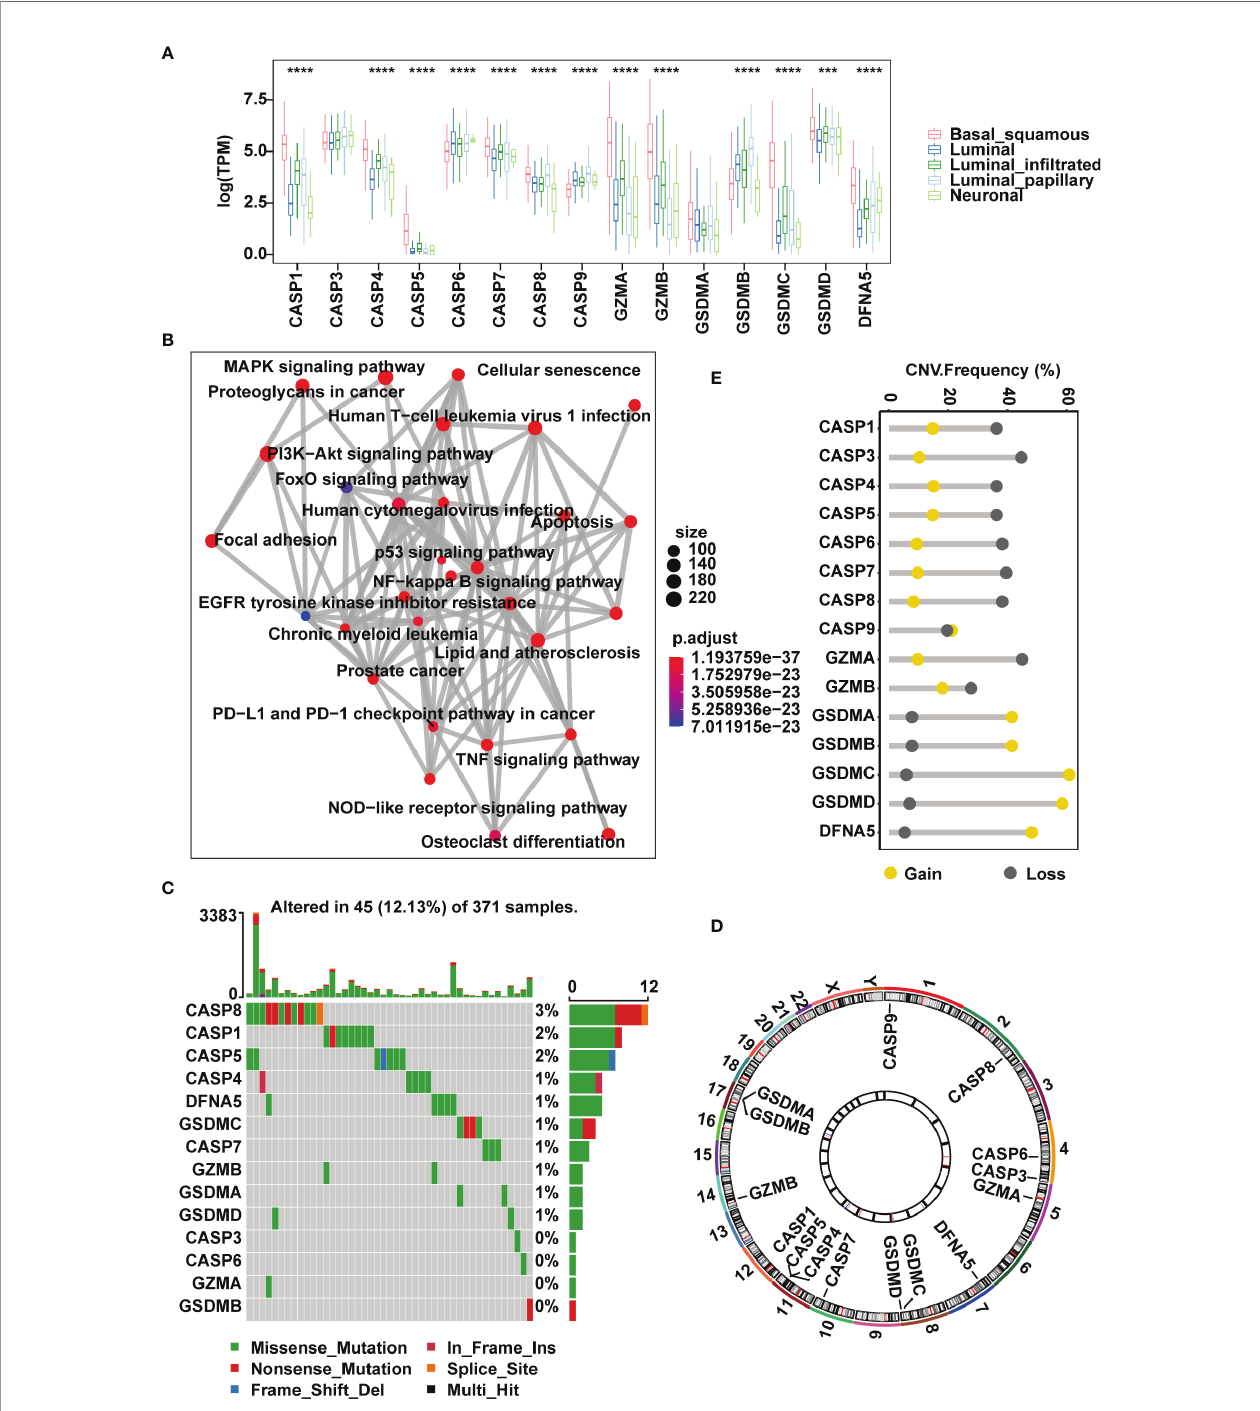
FIGURE 1 | Landscape of genetic and expression variation of pyroptosis regulators in the TCGA-MIBC cohort. (A) The expression of 15 pyroptosis regulators in different MIBC molecular subtypes. (B) An aggregate of potential biological interactions among pyroptosis-related regulators from a one-step protein-protein interaction network. (C) The mutation frequency and classi fi cation of 15 pyroptosis regulators in MIBC. (D) Genomic position of 15 pyroptosis regulators. Bands at the inner circle indicate corresponding expression levels. (E) CNV frequency of 15 pyroptosis regulators. The asterisks represent the statistical P value ( ***p < .001; ****p <